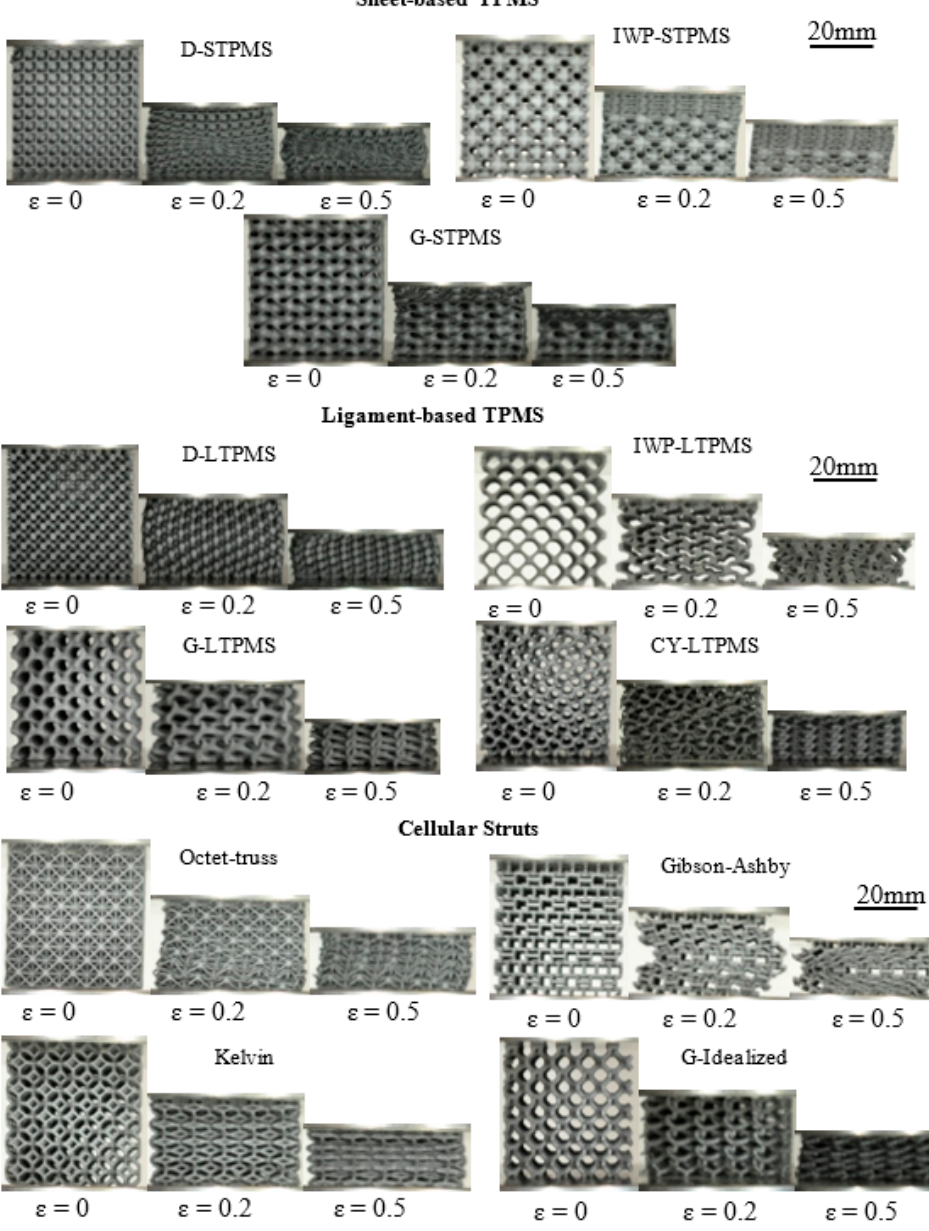
Figure 3. Deformation behavior of sheet-based TPMS, ligament-based TPMS, and strut-based lattices at different relative densities. The deformation behavior are presented at different strain levels; 𝜀 = 0.0 , 𝜀 = 0.2 , and 𝜀 = 0.5 .